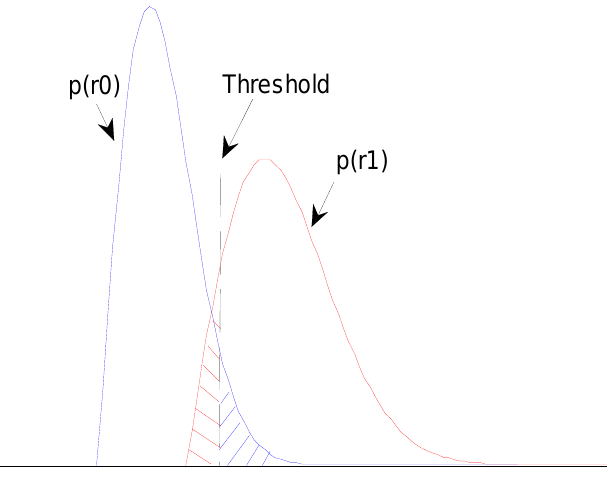
Figure 4. The sketch map of the detection performance by